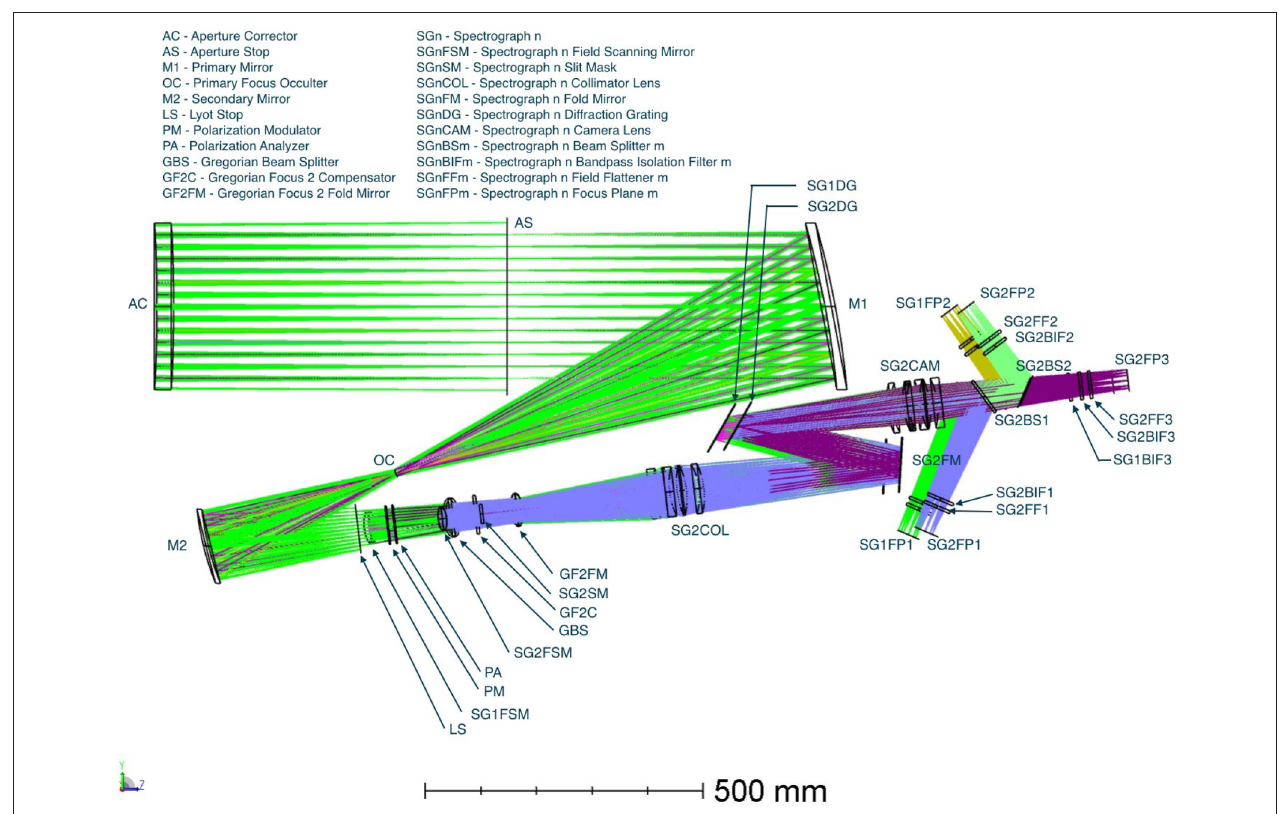
FIGURE 3 | ZEMAX side view of the mxCSM optical system. The effective aperture of the telescope is defined by Lyot Stop (downstream from